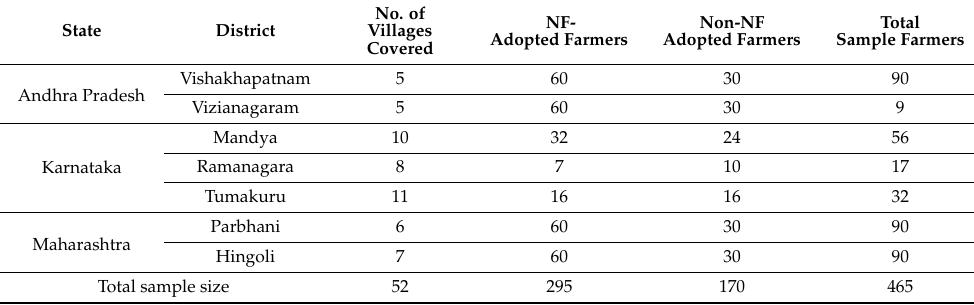
Table 1. Distribution of sample farmers in the